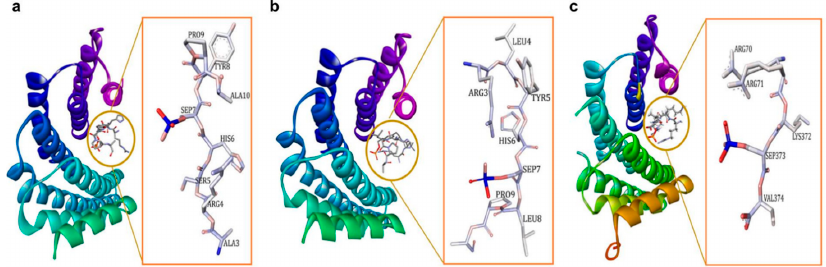
Figure 1. ( a ) 14-3-3 ζ /phosphopeptide complex (mode 1, PDB: 1QJB), ( b ) 14-3-3 ζ /phosphopeptide complex (mode II, PDB: 1QJA), ( c ) 14-3-3 σ /TASK3 peptide (mode III, PDB: